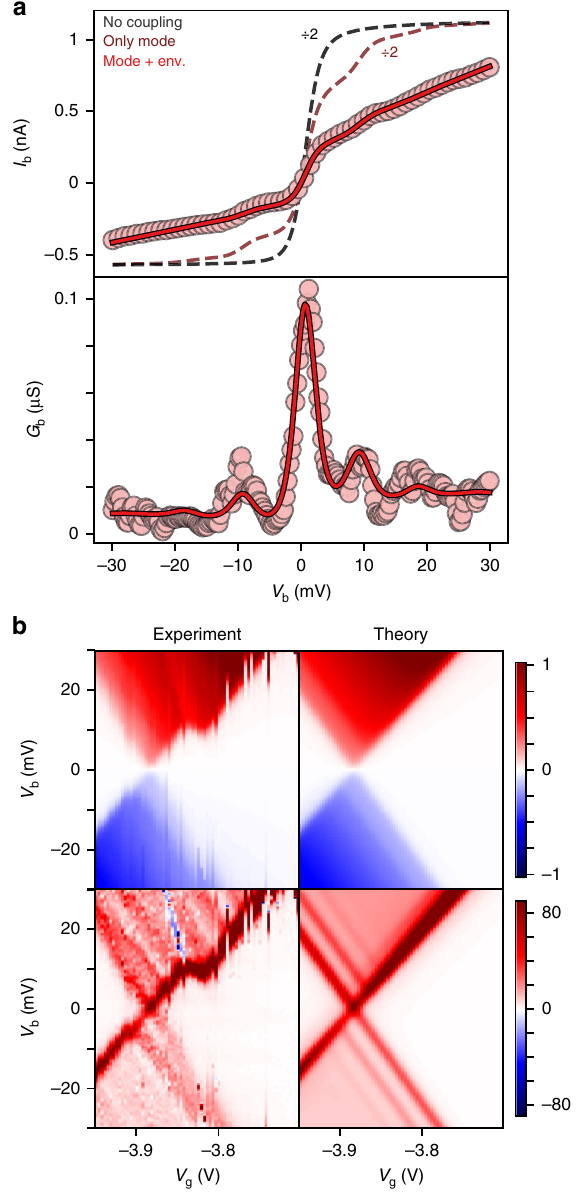
Fig. 2 The contributions of inner and outer sphere vibrational interactions in device A. a Current ( I b ) and differential conductance ( G b ) as a function of bias voltage ( V b ) of device A (circles) at 5 K, corresponding fi t to our model (red line), and corresponding curves without environmental coupling (dark red line) or without vibrational coupling (black line). b Experimental current (left top) and differential conductance (left bottom) maps as a function of bias and gate voltage of device A, and reconstructed maps (right) from the parameters used to fi t the IV trace in a). At higher (positive) bias we observe switching in the stability diagram most likely resulting from a nearby charge trap 30 . This effect is however inconsequential to the phenomena discussed